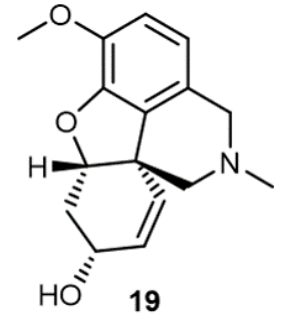
Figure 4: Chemical structure of Galantamine